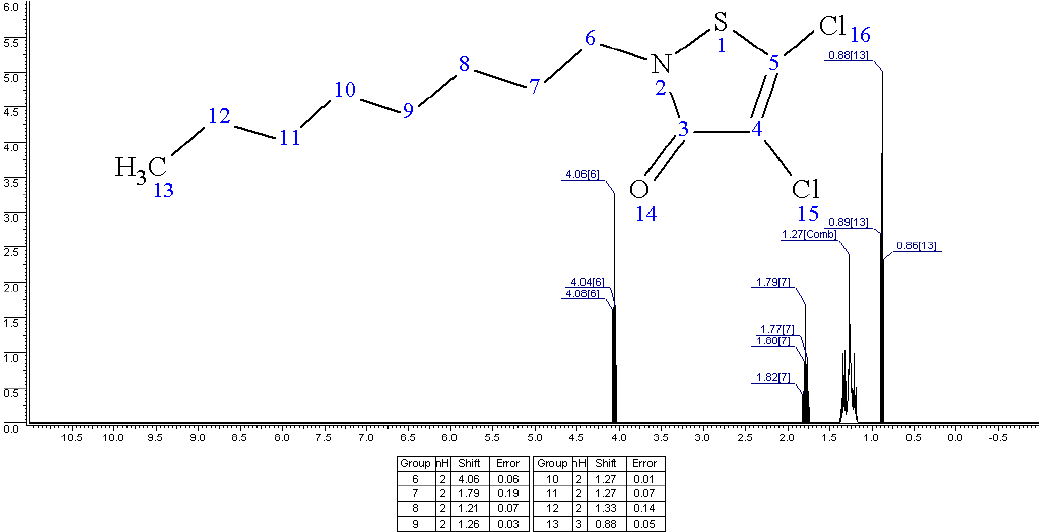
Figure 3. 1 H NMR spectra of DCOIT.